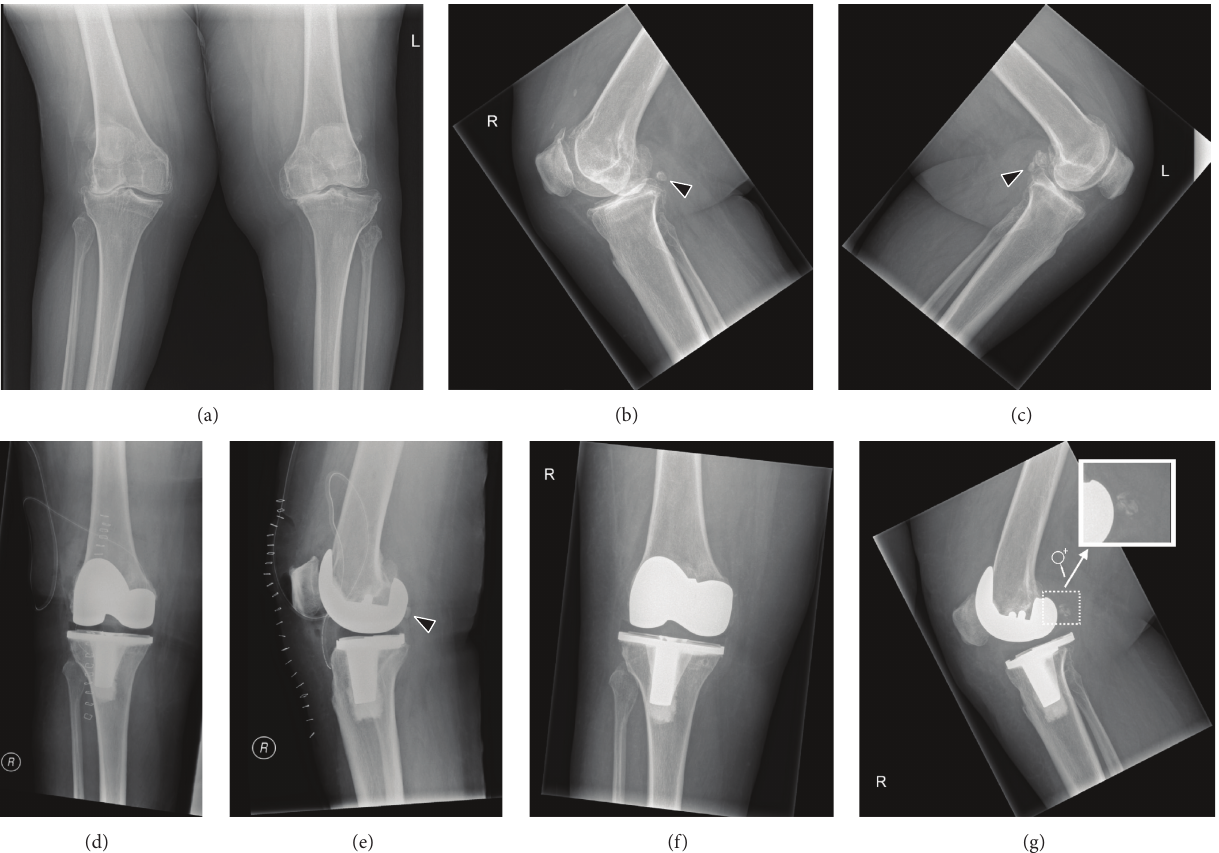
Figure 3: Preoperative (a–c), immediate postoperative (d, e), and 45-day postoperative (f, g) knee radiographs in a 63-year-old woman who underwent total knee arthroplasty of the right knee because of symptomatic knee osteoarthritis with valgus malalignment. Preoperative knee radiographs(anterior-posterior(a)andlateralviews(b,c)ofbothknees)showosteophytes,scleroticchanges,andseverejointspacenarrowing of right-sided lateral and left-sided medial femorotibial compartments, in keeping with femorotibial osteoarthritis. There is approximately 23 ∘ valgus malalignment of the right knee and approximately 7 ∘ varus malalignment of the left knee. Note the normal appearing fabellae ((b) and (c) arrowheads). Immediate postoperative radiographs of the right knee on the same day of surgery (anterior-posterior view (d) and lateral view (e)) show a good position of the total knee arthroplasty with a well-aligned knee joint and with a still normal appearing fabella ((e) arrowhead). However, 45-day postoperative radiographs of the right knee (anterior-posterior view (f) and lateral view (g)) show a shattered patella ((g) including magnified view of the